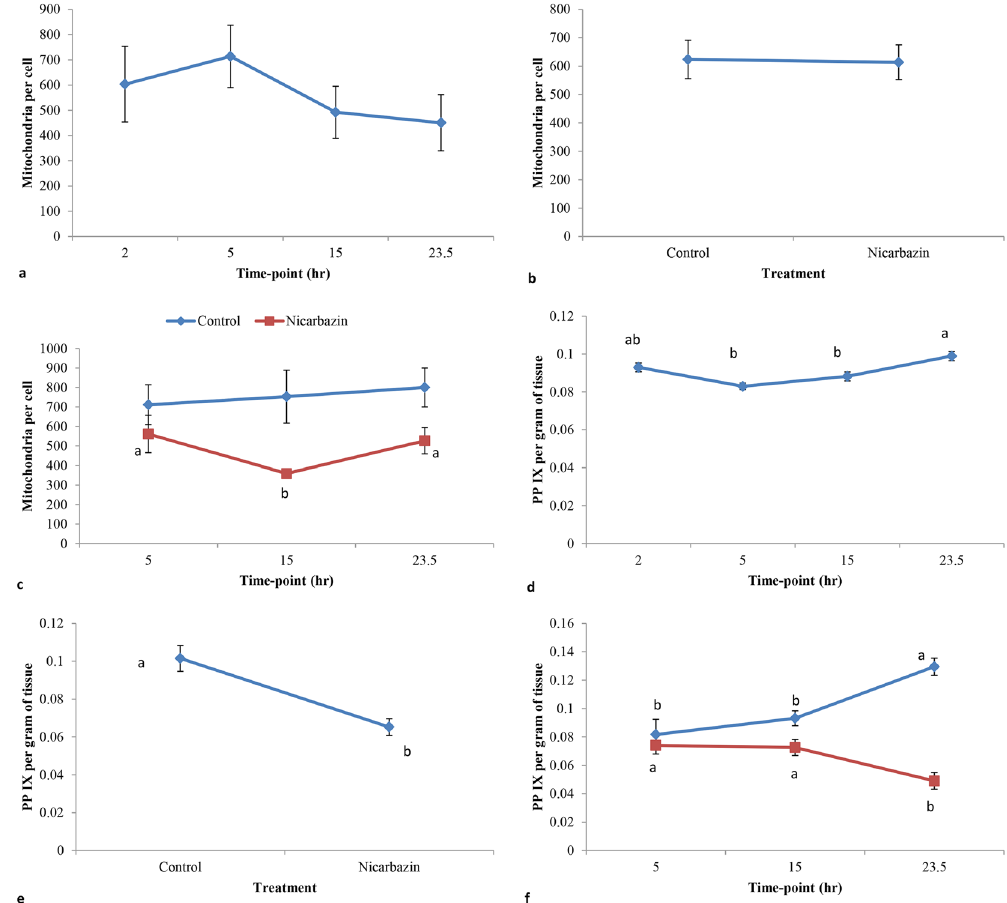
Figure 2. Mitochondria per cell and PP IX per gram of shell gland tissue affected by time-points of eggshell formation and nicarbazin treatment. ( a ) Mitochondria per cell in the shell gland tissue of laying hens affected by four different time-points of eggshell formation. ( b ) Mitochondria per cell in the shell gland tissue between control and nicarbazin treated laying hens. ( c ) Mitochondria per cell affected by interaction between three different time-points and nicarbazin treatment. ( d ) PP IX (in nMoles) per gram of shell gland tissue affected by four different time-points of eggshell formation. ( e ) PP IX (in nMoles) per gram of shell gland tissue between the control and nicarbazin treated hens. ( f ) PP IX (in nMoles) per gram of shell gland tissue affected by three different time-points and nicarbazin treatment. Values are mean and bars represent standard error. Different superscripts ( a , b ) show significant difference.